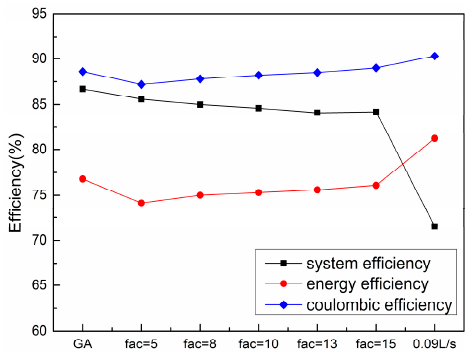
Figure 15. Performance analysis of the stack under different flow control strategies.